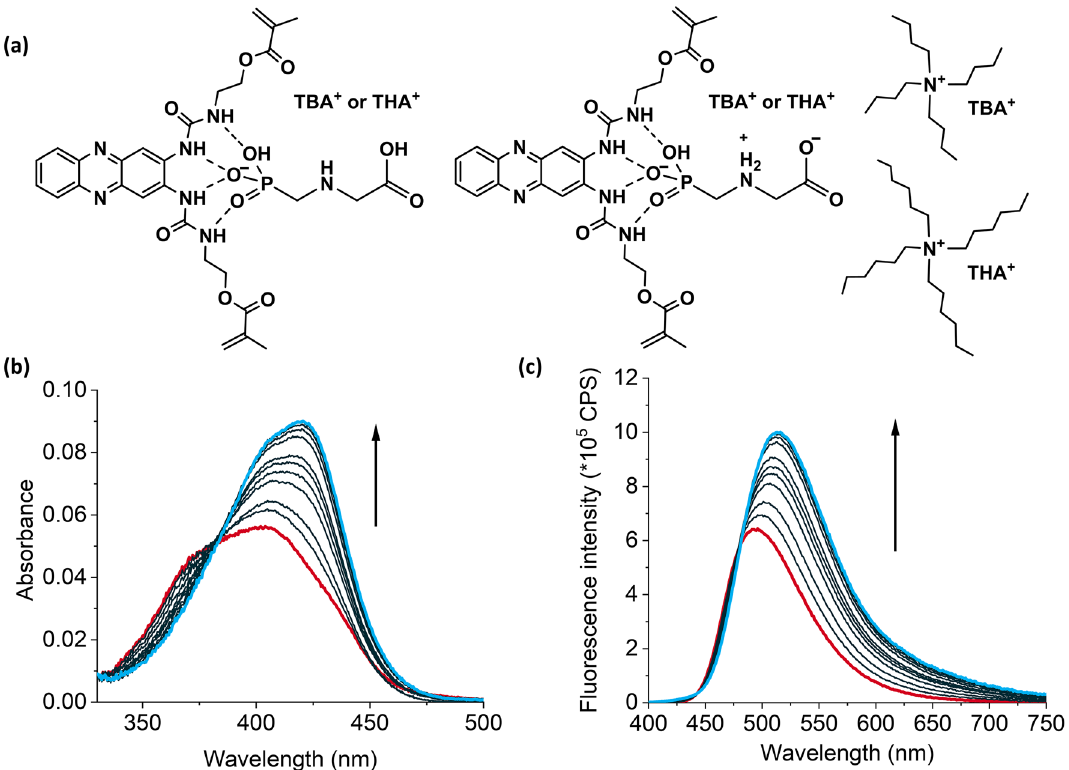
Figure 1. ( a ) Possible modes of interaction between GPS-TXA with I in chloroform, showing the structures of TBA + and THA + counterions. ( b ) Absorption and ( c ) fluorescence spectra (λ ex = 385 nm) upon titration of I (4.8 µM) with up to 68 equivalents of GPS-TBA in chloroform. Spectra for titration of I with GPS-THA are identical and are shown in Fig. S3, Supplementary